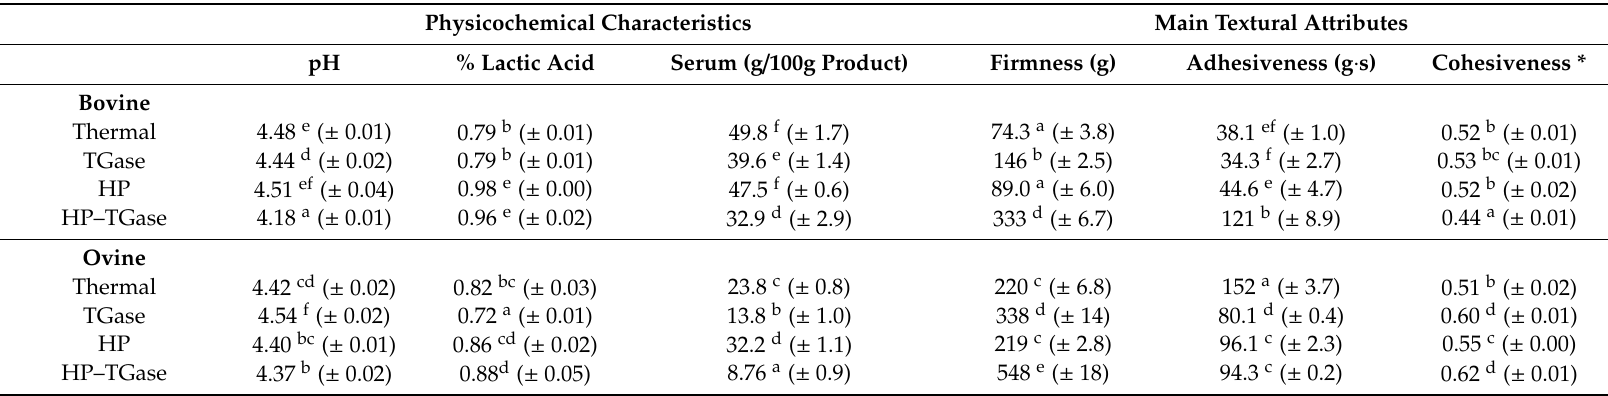
Table 3. Physicochemical characteristics and main textural attributes of bovine and ovine yoghurt samples as evaluated after 3 (D + 3) days of their